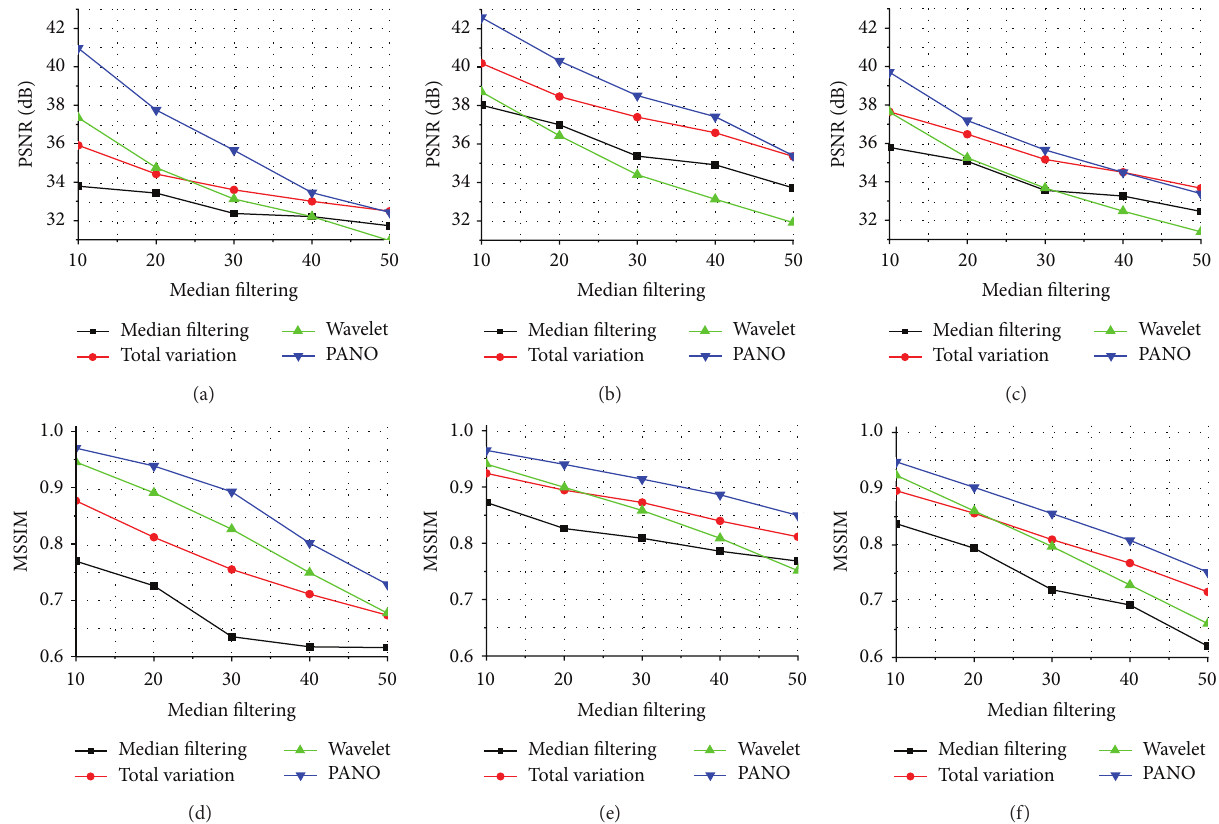
Figure 6: Denoising performance for salt-and-pepper noise. (a), (b), and (c) are the PSNRs of image Barbara , House, and Boat ; (d), (e),